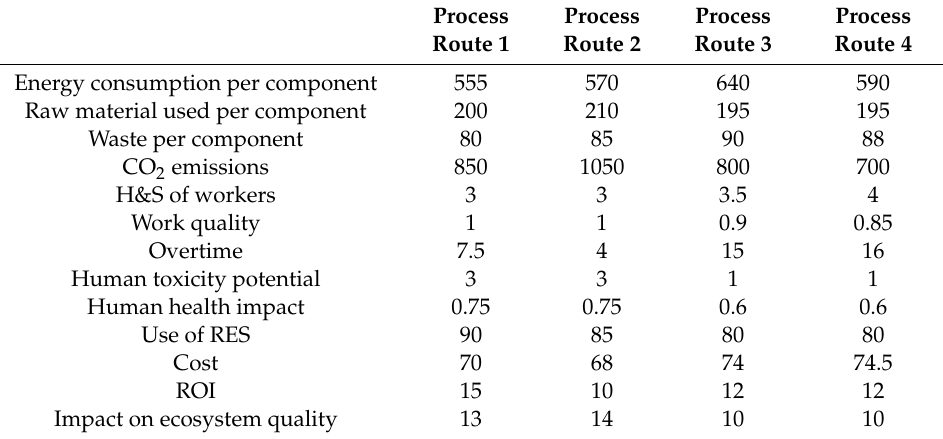
Table 3. Decision matrix for medium demand.